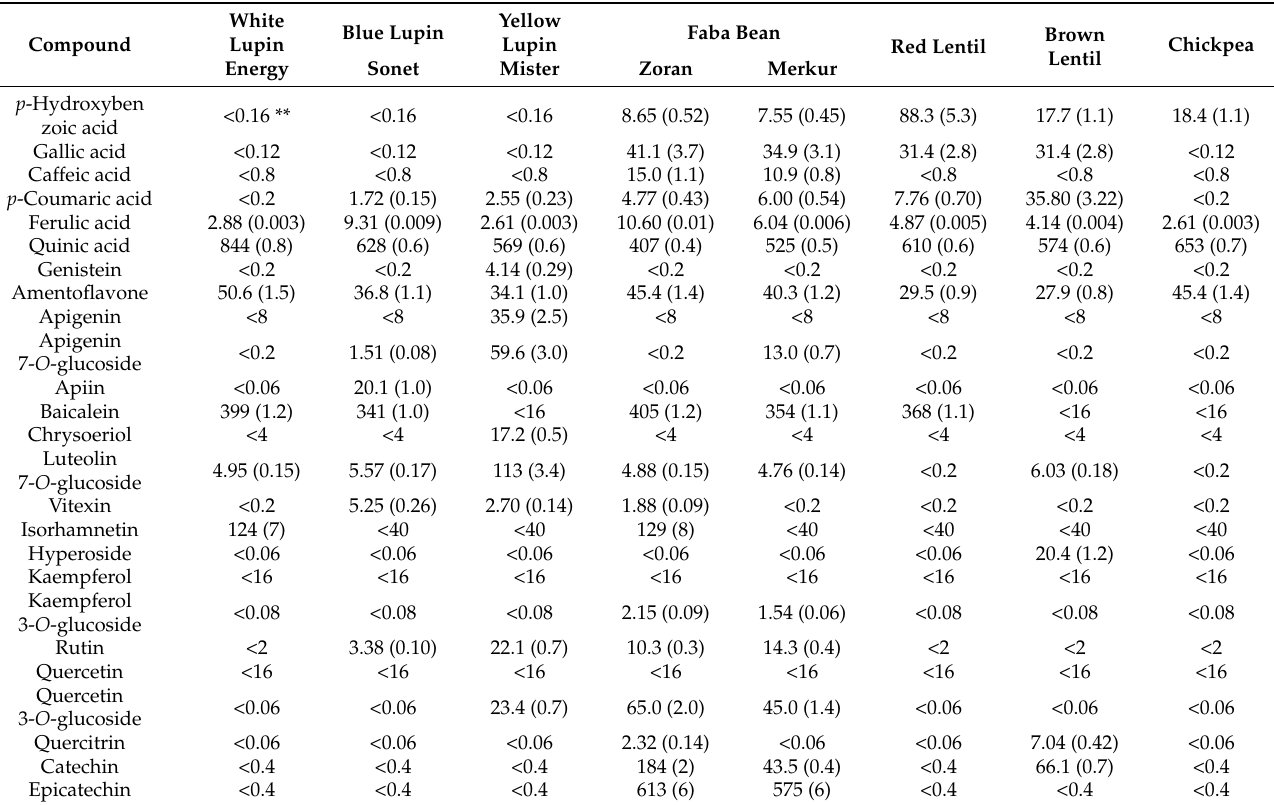
Table 3. Quantification of phenolic compounds ( µ g/g dry weight (DW)) in lupins (white, blue and yellow), faba bean, lentil and chickpea seeds *.